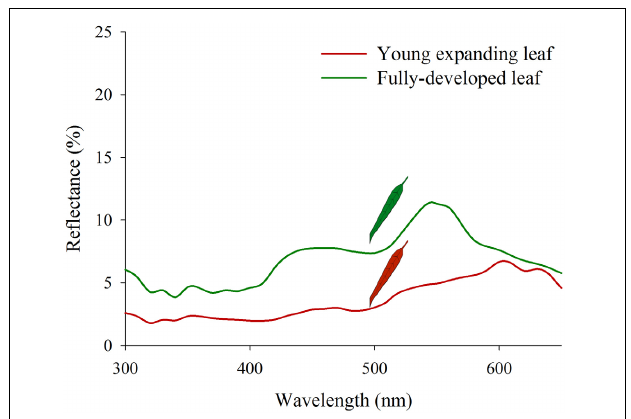
FIGURE 9 | Reflectance spectra of young (“red”) and older (“green”) Eucalyptus camaldulensis